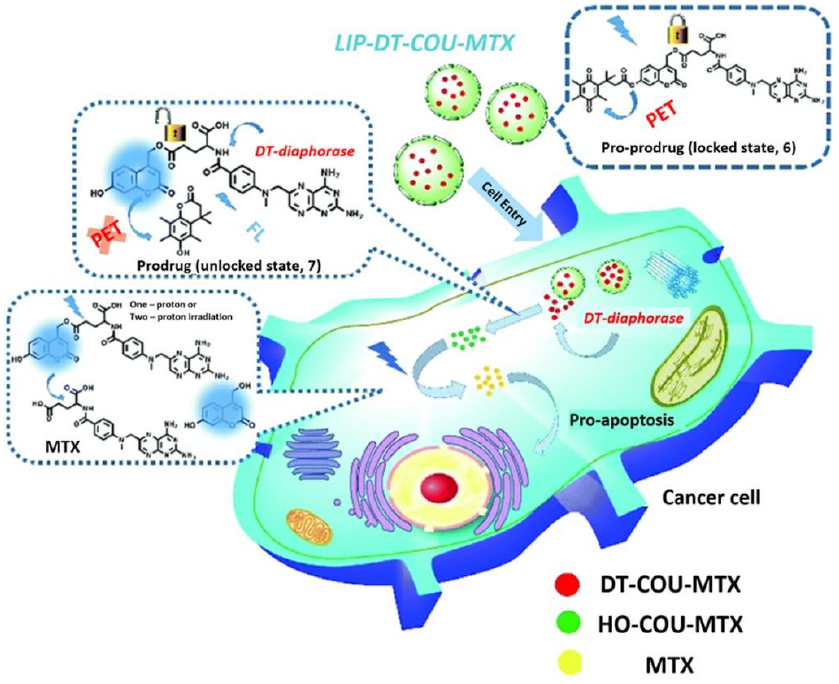
Figure 3. Schematic overview of a pro-prodrug nanosystem for imaging and therapy. Before enzyme activation, in the locked state pro-prodrug, the coumarin is a dormant photo-trigger with quenched fluorescence, while the enzymatic reaction leads to the cleavage of the quinone propionic acid group, which not only restores the fluorescence of coumarin but also makes it an active photo-trigger, leading to the release of the active drug. Reproduced from [35] with permission, copyright 2018, Royal Society of Chemistry.